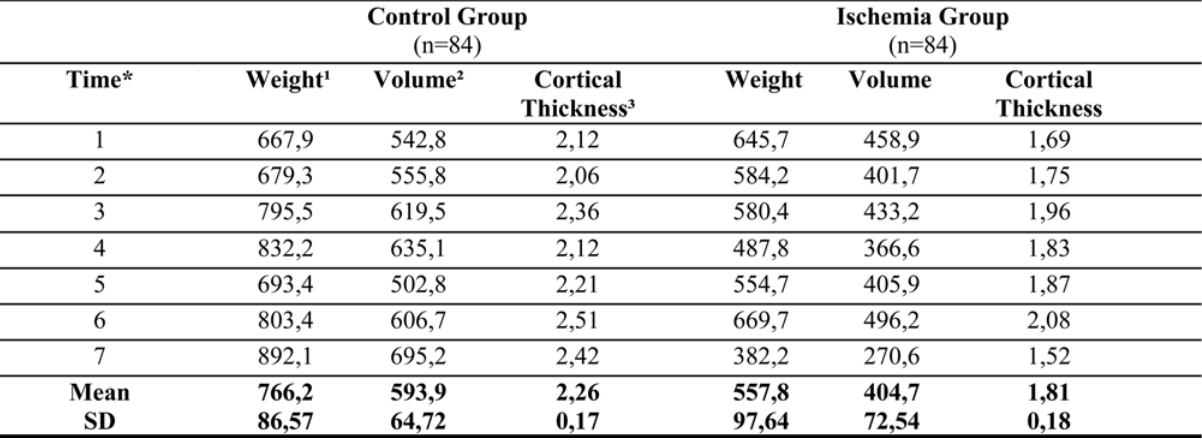
TABLE 1 - Comparison between control and isquemia groups for renal weight, volume and cortical thickness at different times of the experiment.